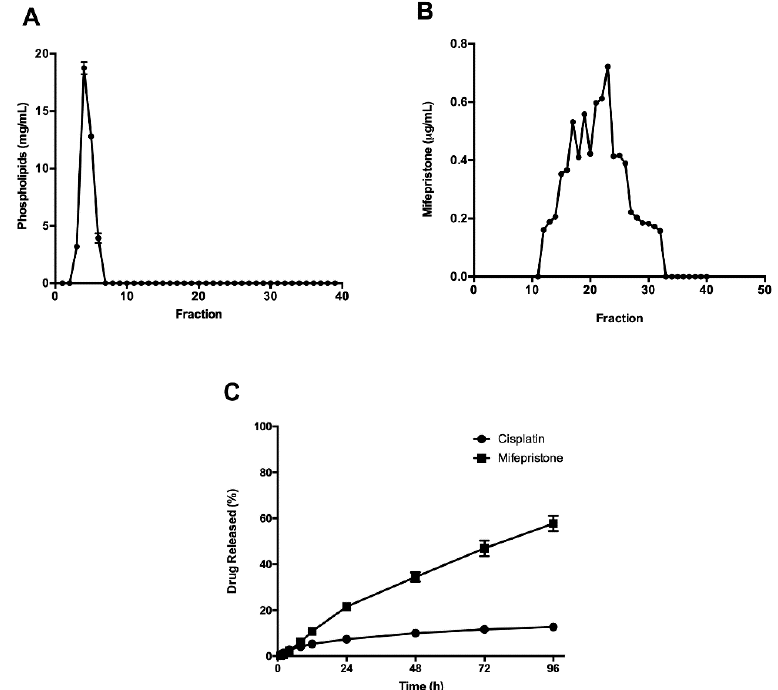
Figure 2. Following the encapsulation of cisplatin and mifepristone in the liposomes, the physicochemical characterization of L-Cis / MF was carried out by measuring: ( A ) the phospholipid concentration in the fractions derived from the liposomes; ( B ) non-encapsulated mifepristone extracted from fractions 11–33; ( C ) the percentage of cisplatin (black circles) and mifepristone (black squares) released from the formulation during 96 h of incubation at room temperature. Data are expressed as the mean ± SD ( n = 3).